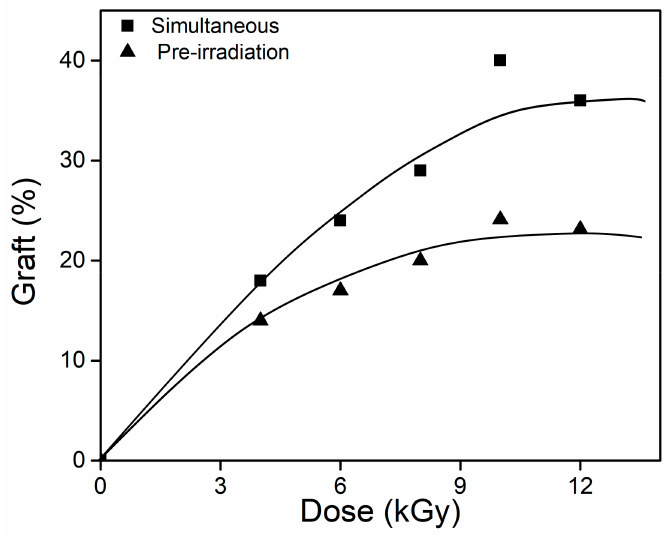
Figure 4. Binary graft percentage as a function of dose for (cid:4) direct and (cid:78) pre-irradiation